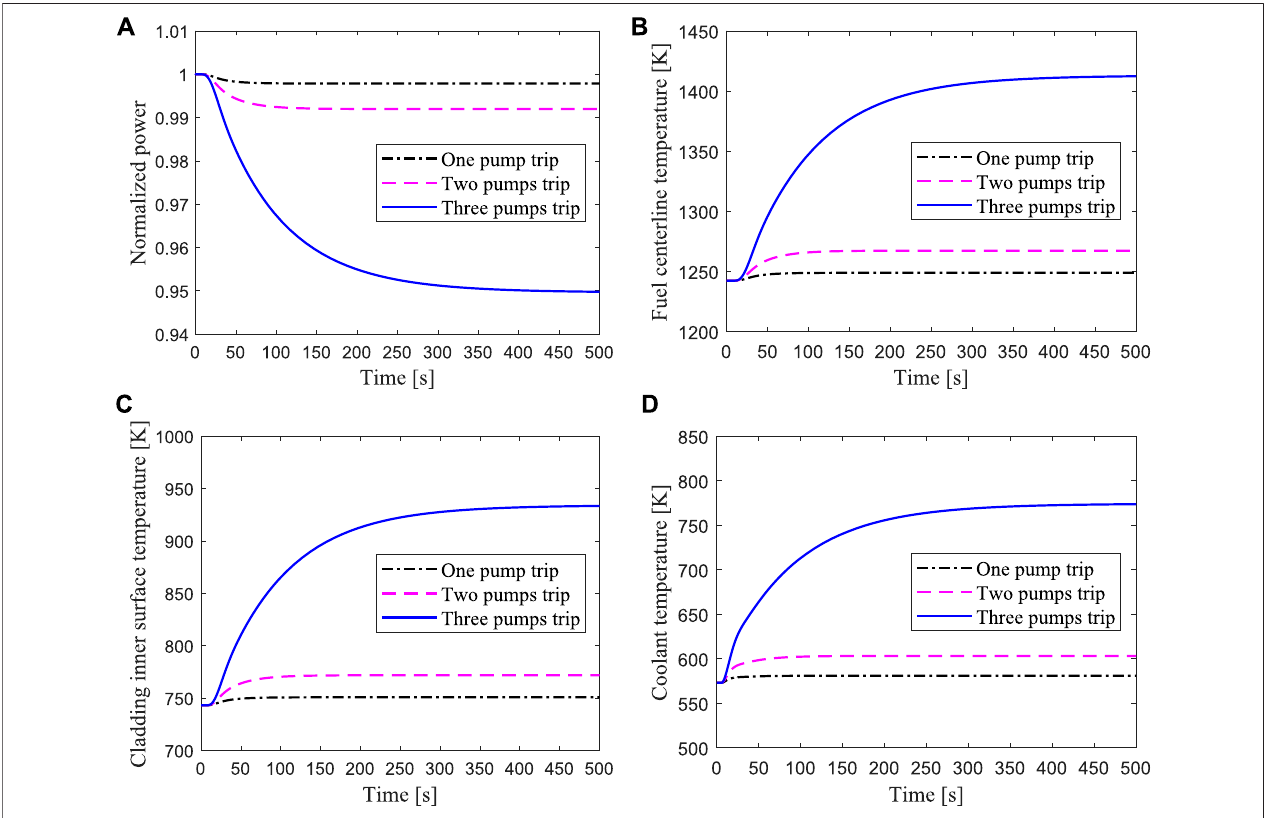
FIGURE 16 | Transient responses of the hottest channel for unprotected loss of heat sink due to one, two or three secondary pumps trip respectively.